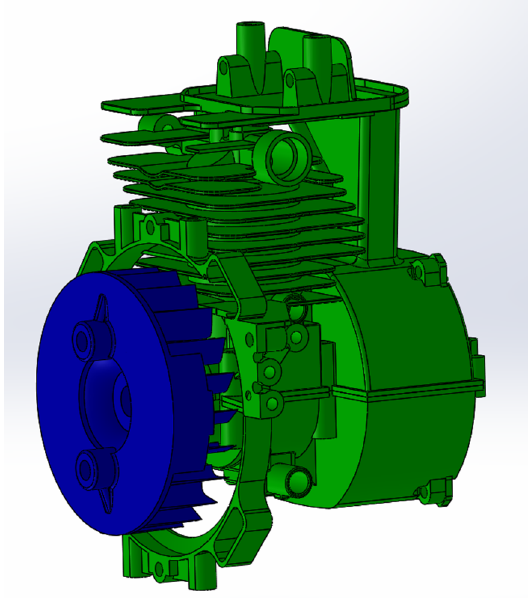
Figure 11. Honda GX35 serial engine in SolidWorks environment.